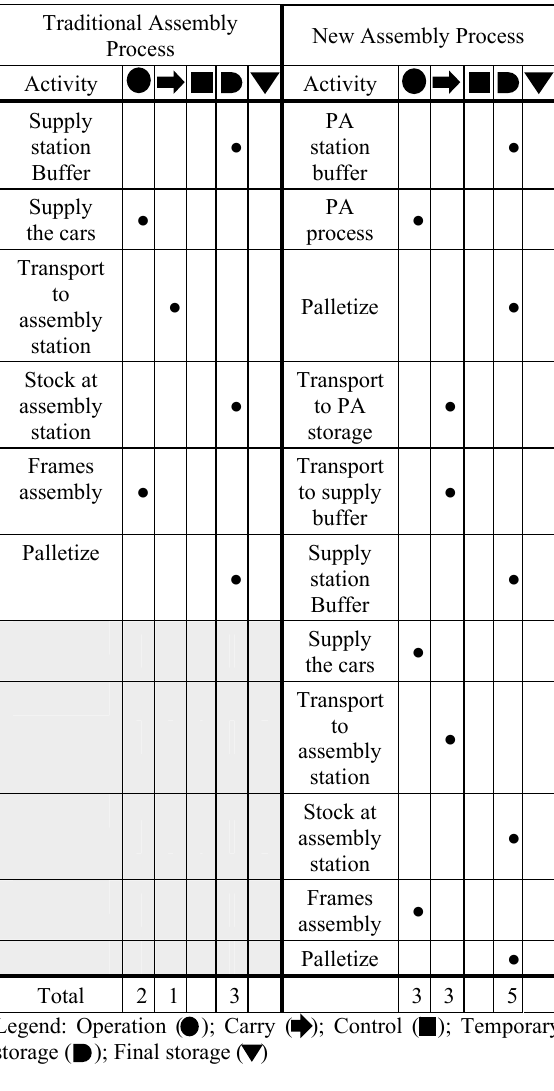
Table 3. Assembly material sequential graphic comparison Traditional